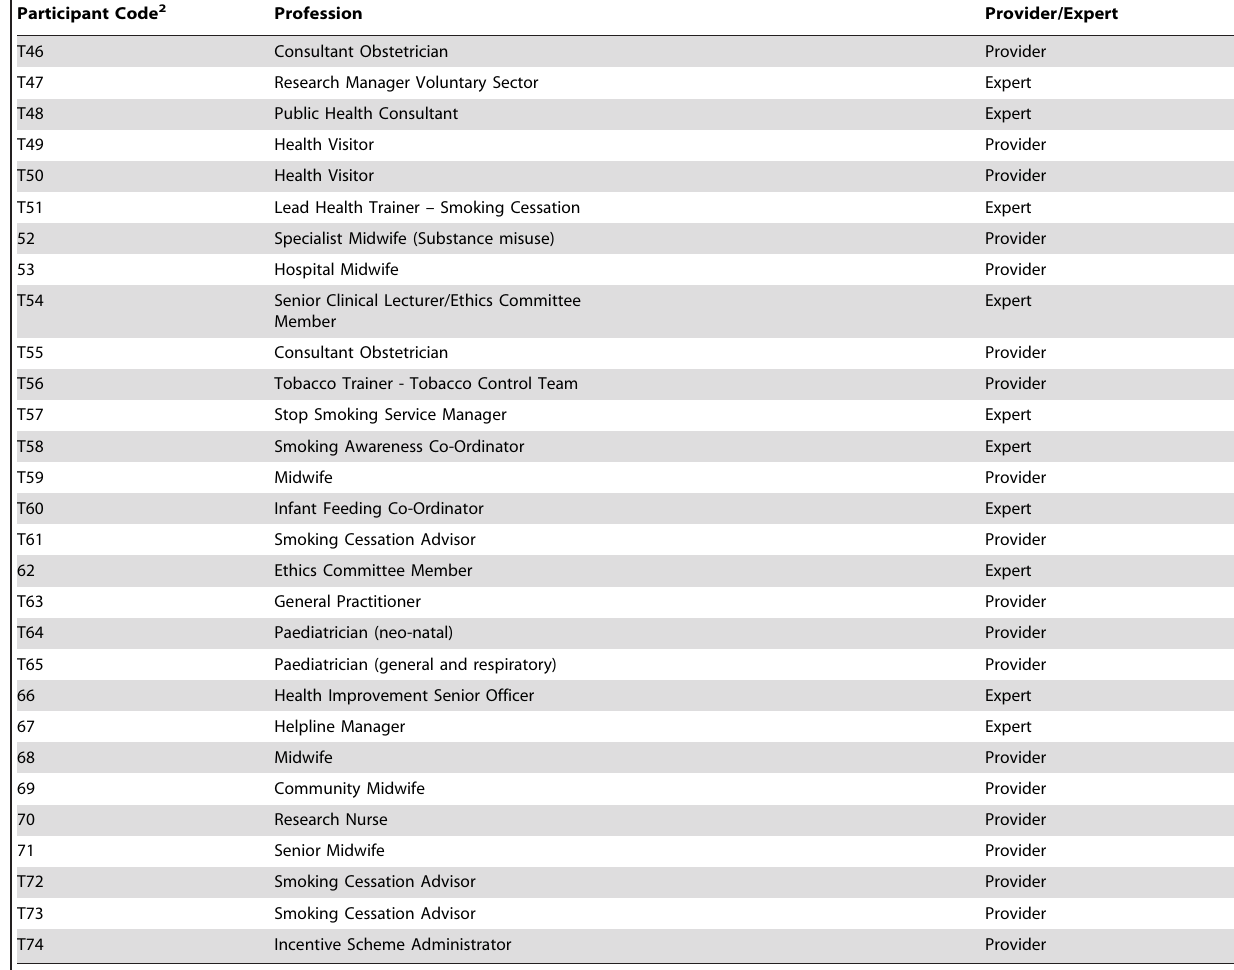
Table 7. Interviews – providers/experts 1